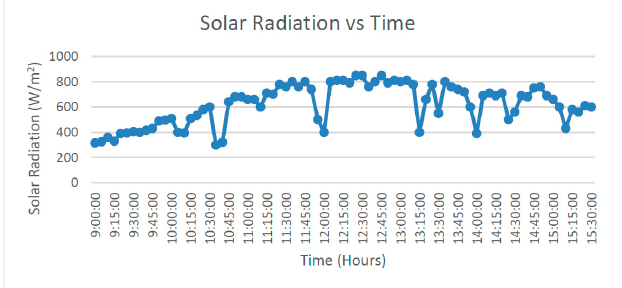
Figure 6. Solar radiation curve versus time of a PV reference cell.